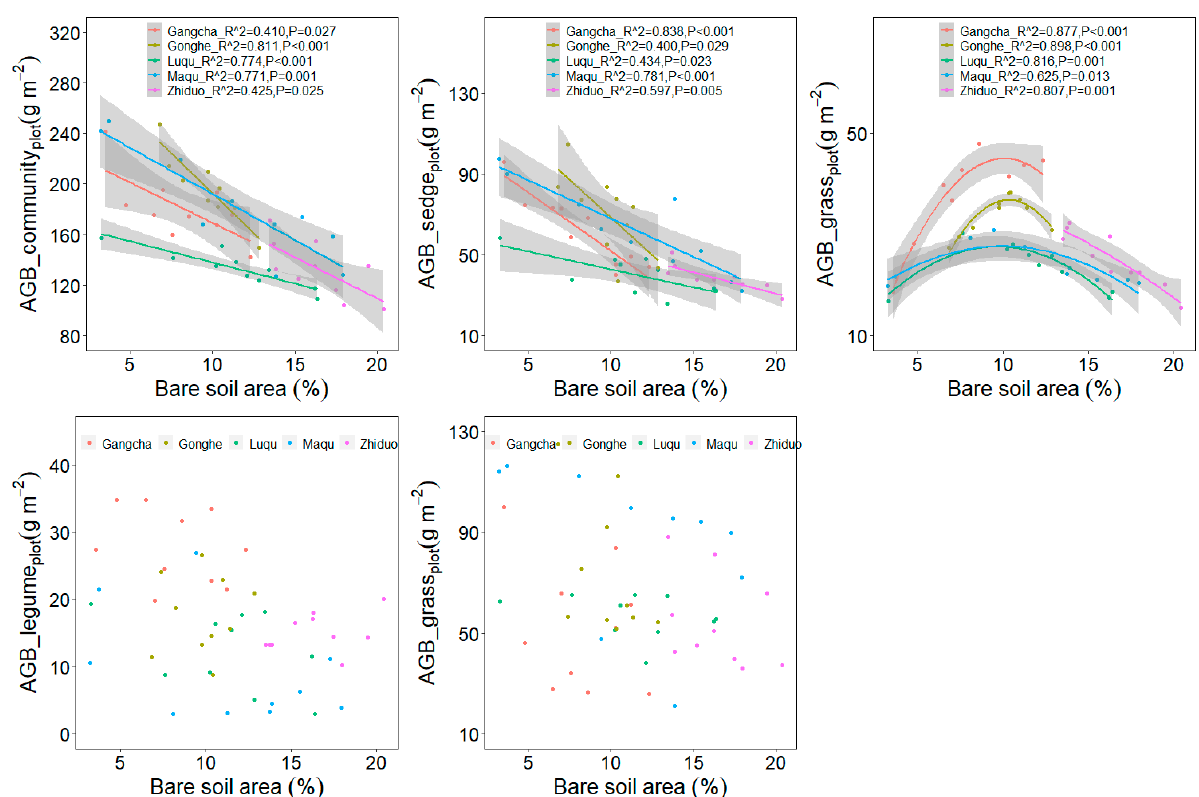
Figure 5. Relationship between plant aboveground biomass at quadrat scale and the bare soil area (%) in each site based on a LM. AGB, aboveground biomass.